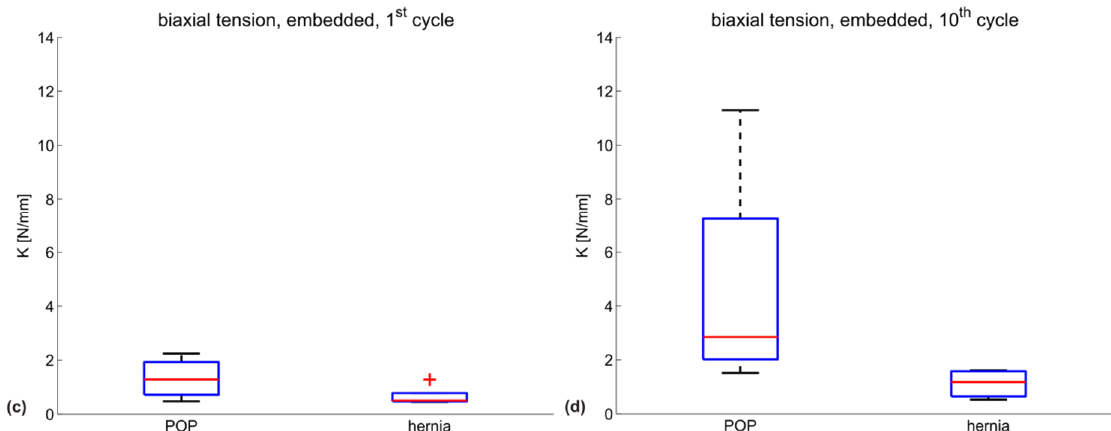
Figure 5. Box plots for biaxial secant stiffness K bi (N/mm) or all meshes in four configurations: ( a ) dry mesh, first cycle; ( b ) dry mesh, 10th cycle; ( c ) embedded mesh, first cycle; ( d ) embedded mesh, 10th cycle. The red line marks the median of the group; the box represents the 25th and 75th percentile; the extended whiskers the most extreme data points. The + sign indicates an outlier.